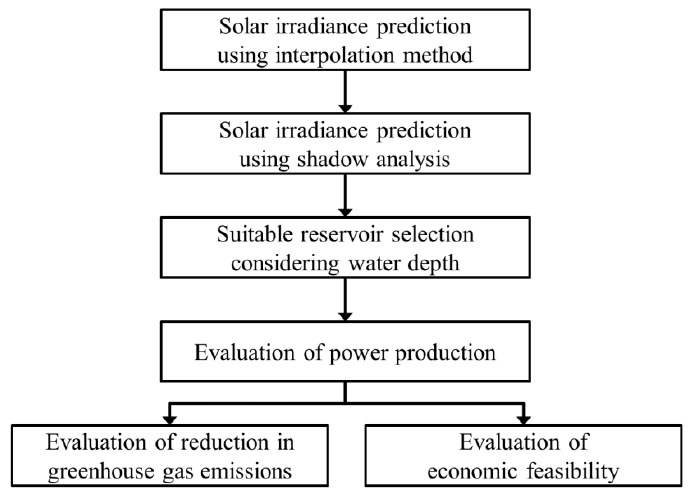
Figure 3. Overall study process to select suitable reservoirs and assess the potential of floating photovoltaic systems in Korea.